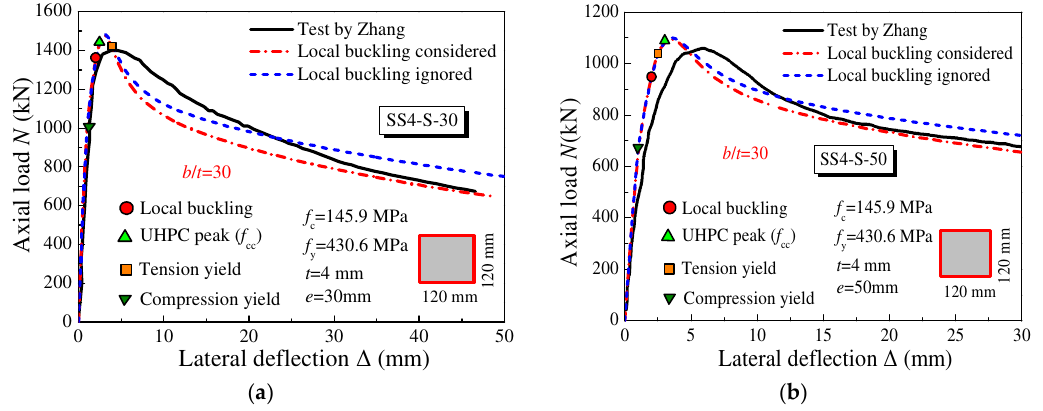
Figure 8. The comparisons of predicted N-Δ curves with test results (Zhang et al. [35]). ( a ) SS4-S-30 ( b ) SS4-S-50.